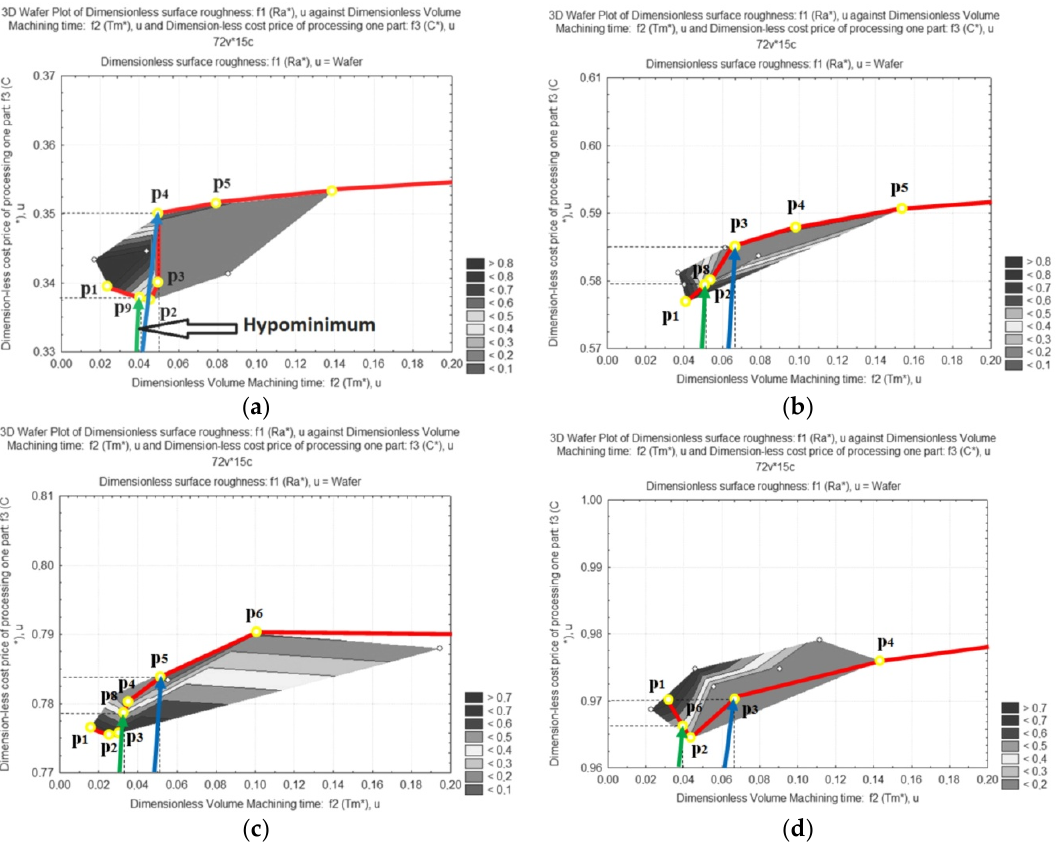
Figure 13. Global and local minima on the Pareto curve for the AA6061 aluminum workpiece: ( a ) obtained with ET-500 extrusion; ( b ) for the ECAP-2 hardened workpiece; ( c ) for the ECAP-4 hardened workpiece; ( d ) for the ECAP-6 hardened workpiece.